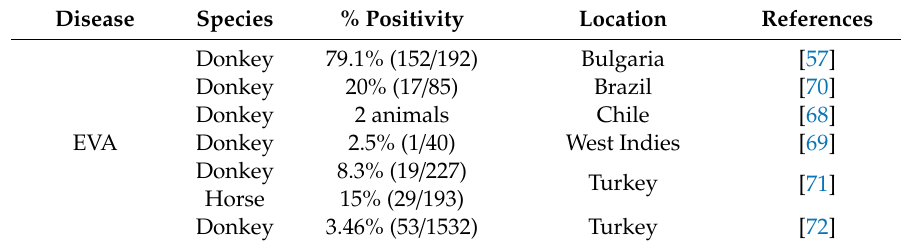
Table 3. Studies of the occurrence of Alphaarterivirus equid , including donkeys and / or mules, from 2009 to